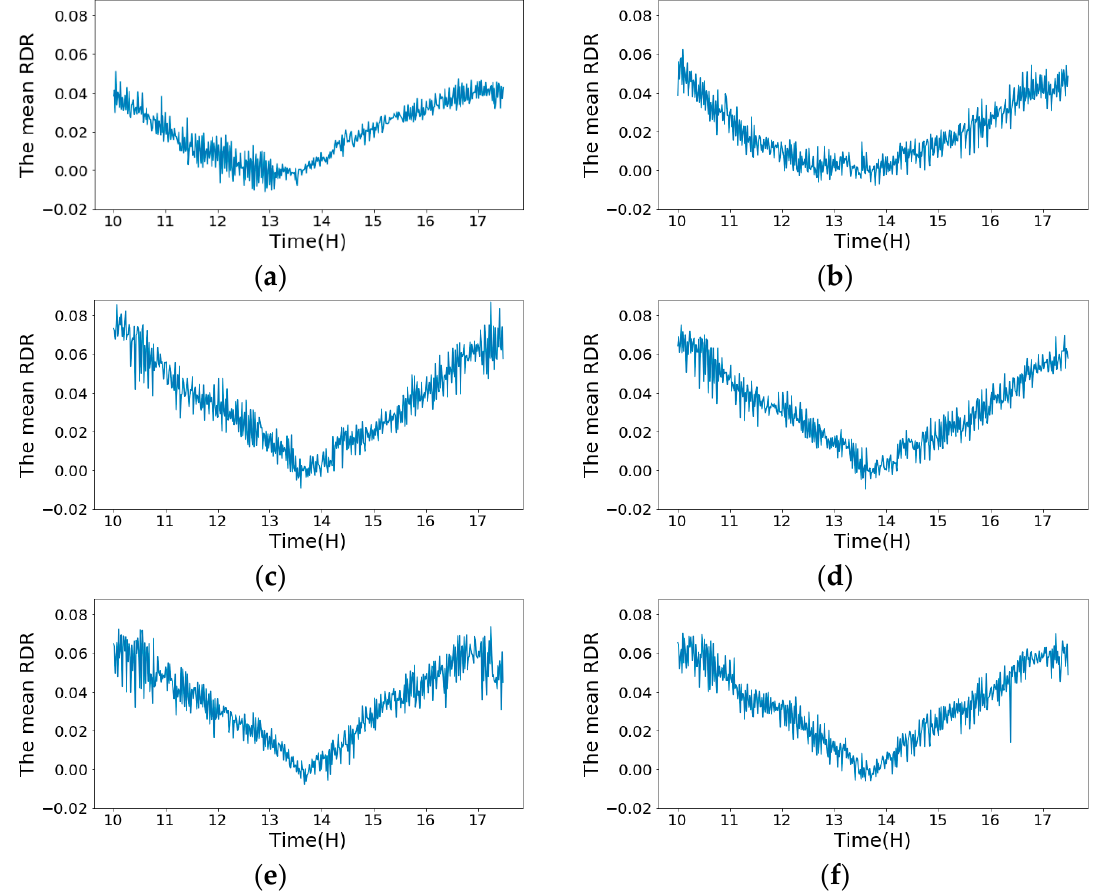
Figure 6. The mean RDR curves of six plant plots versus time (H). ( a ) HN and B73 × Mo17; ( b ) HN and P1105AM; ( c ) MN and B73 × Mo17; ( d ) MN and P1105AM; ( e ) LN and B73 × Mo17; ( f ) LN and P1105AM.